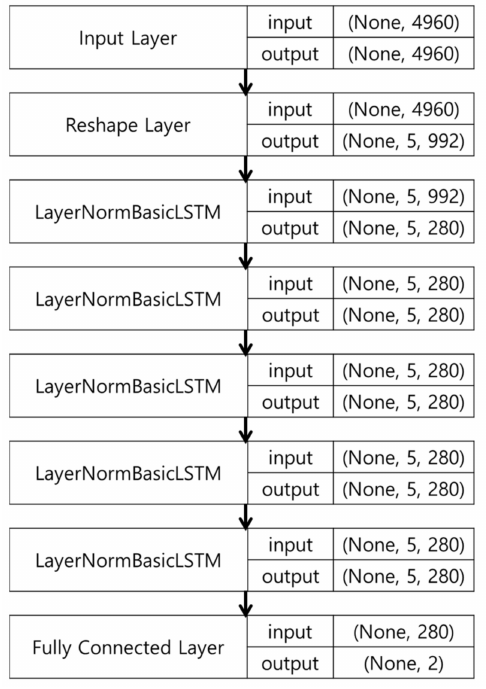
Figure 2. Proposed deep learning layer at p =